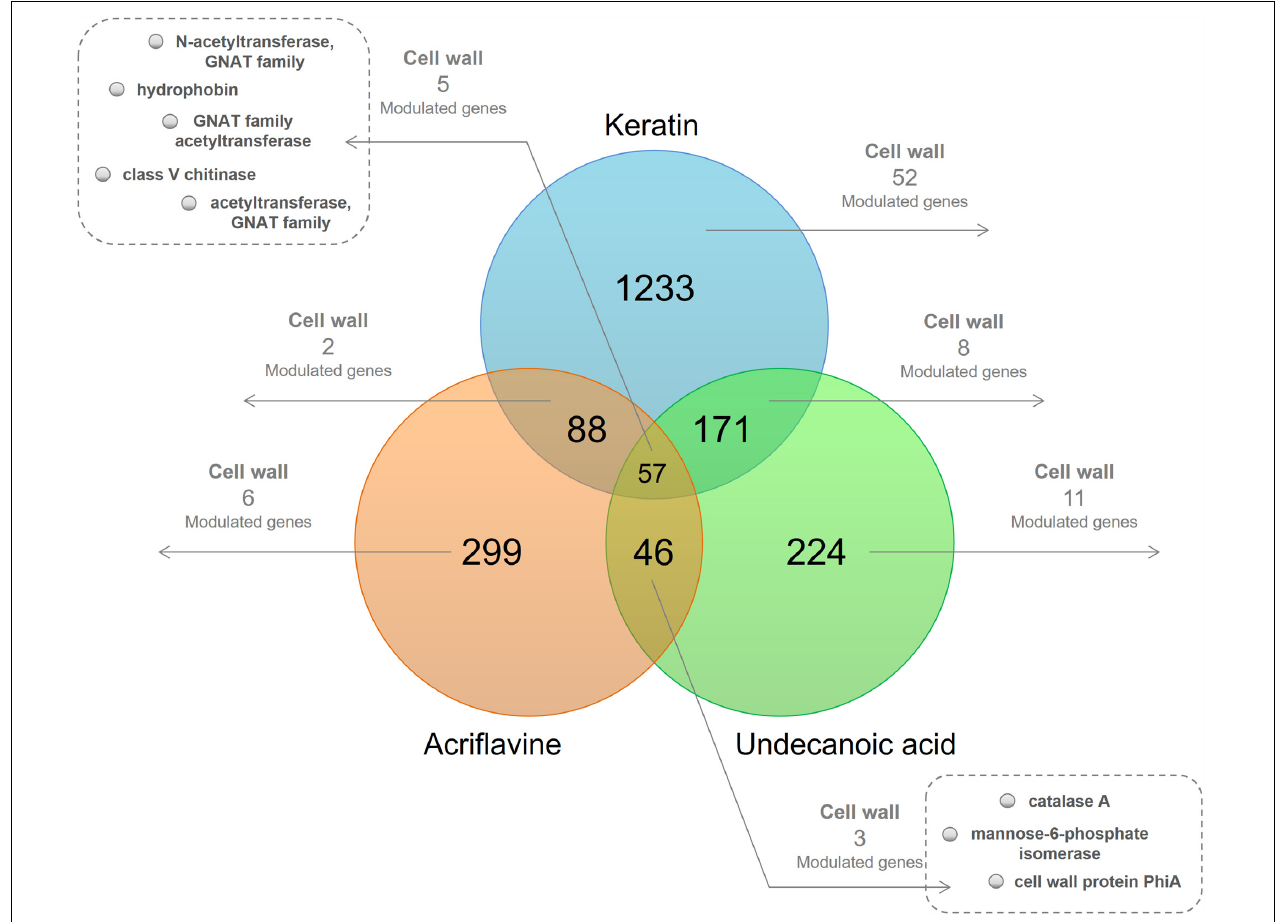
FIGURE 1 | Venn diagram of the differentially expressed genes (DEGs) in the libraries. At the intersections, number of genes modulated in at least one of the time points of each of the three libraries. The number of modulated cell wall-related genes present in at least one of the time points are highlighted.